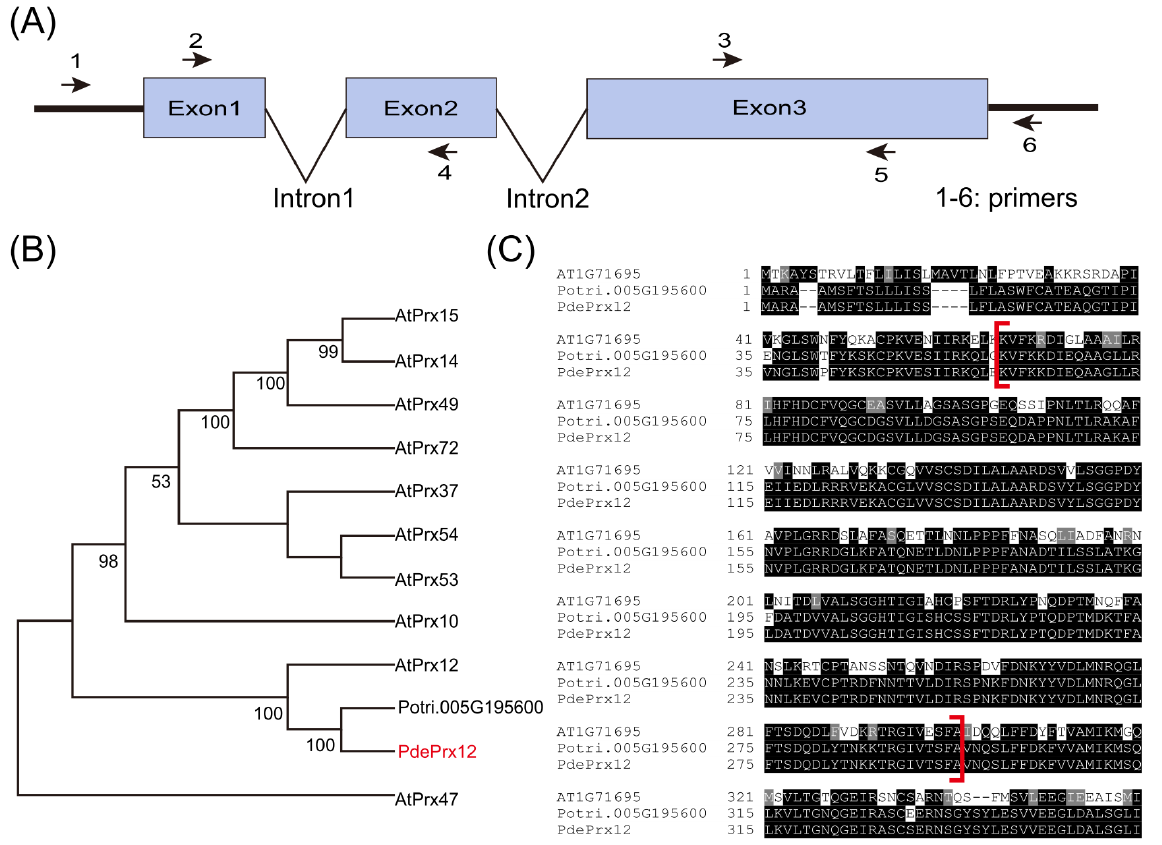
Figure 1. Characteristics of the PdePrx12 gene. ( A ) Structure of the PdePrx12 gene and primer posi-